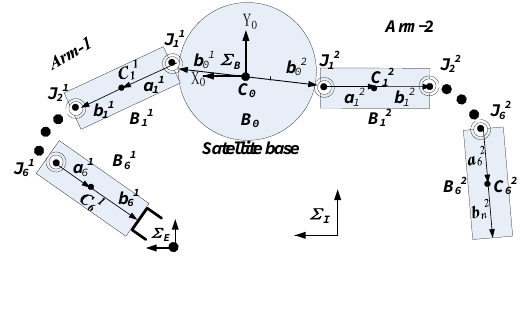
Figure 1. Model of a Dual-arm Space